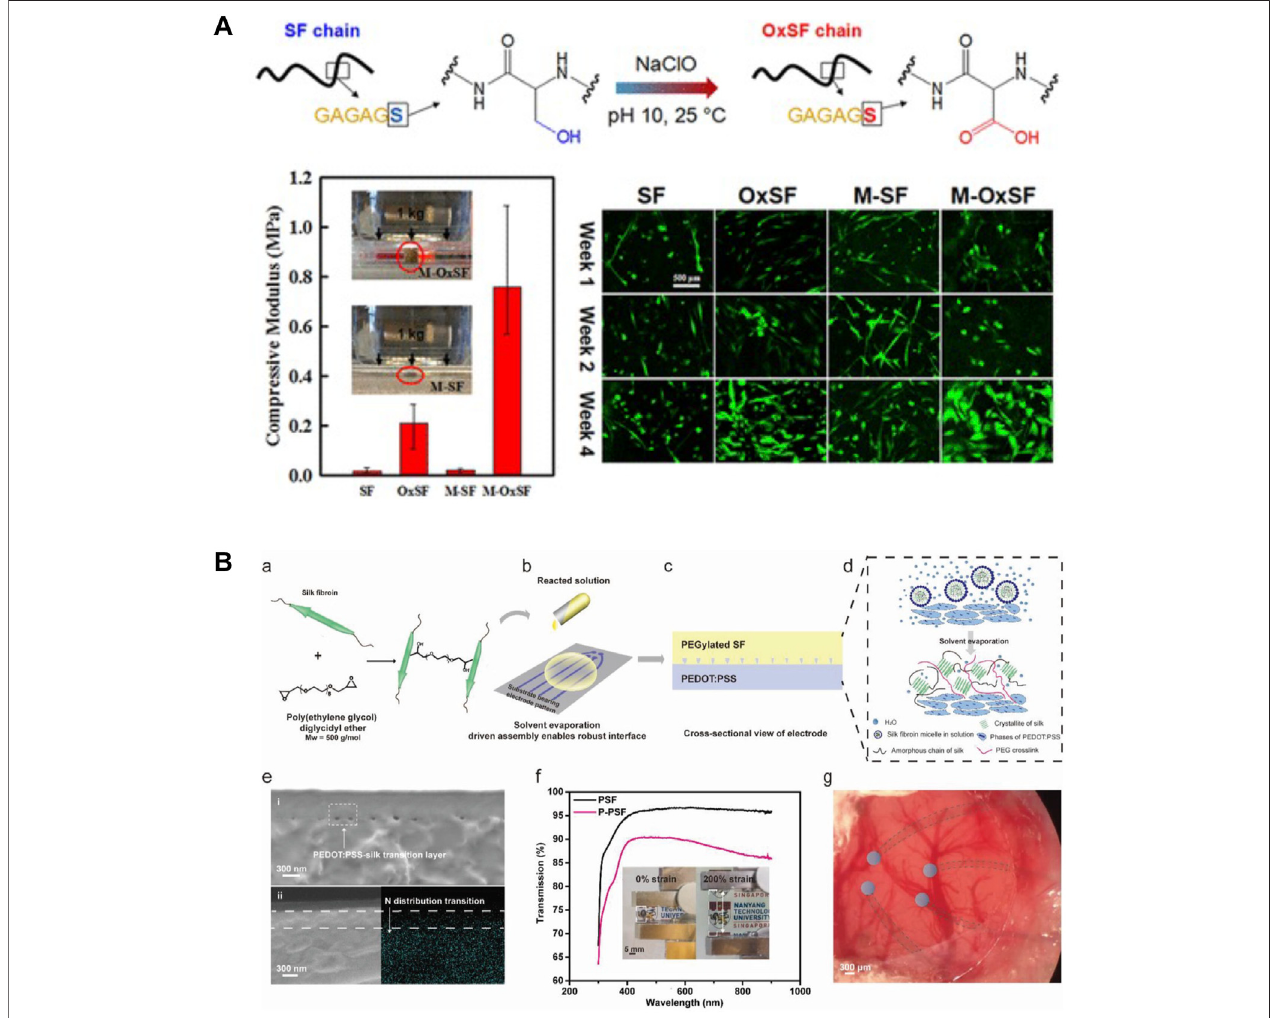
FIGURE 5 | Material modi fi cation strategies on silk-based materials. (A) Silk fi broin (SF) was oxidized using sodium hypochlorite (NaClO). The oxidized silk (OxSF) scaffoldsshowed10timeshighercompressivemodulus(211±75 kPa)inthehydratedstatethantheSFscaffolds.Meanwhile,themineralizedOxSFscaffolds(M-OxSF) possessedagreatermodulusof758±189 kPa.Humanbonemarrow-derivedmesenchymalstemcells(hMSCs)proliferatedanddifferentiatedontheoxidizedscaffolds in vitro . Adapted withpermission from ref(Zhenget al., 2016).Copyright2016AmericanChemicalSociety. (B) Designoftransparent, stretchable,and implantable SF-based hydrogel electrode. SF was crosslinked with poly (ethylene glycol) diglycidyl ether and then wassubsequently poured onto PEDOT:PSS to form a thin fi lm silk electrode. Solvent evaporation allowed more interactions between silk and PSS. The resultant electrodes were highly transparent and stretchable. Adapted with permission from ref (Cui et al., 2021). Copyright 2021